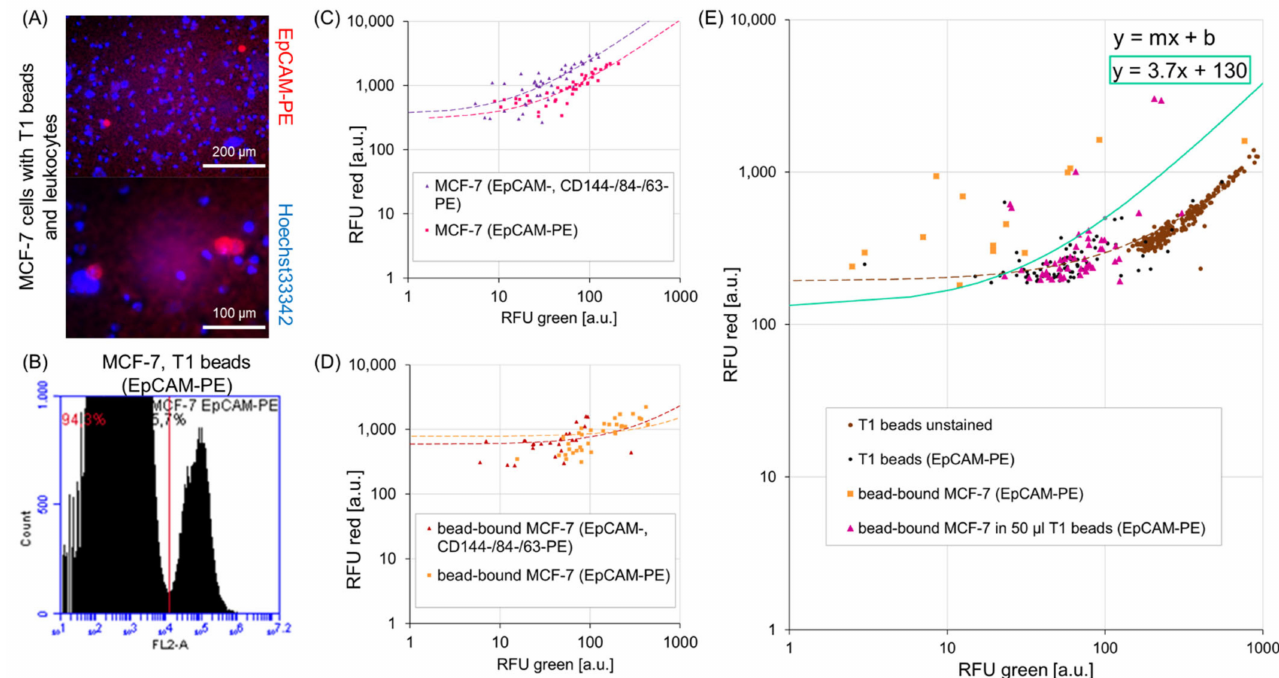
Figure 4. Selective optomicrofluidic detection of antibody-stained bead-bound MCF-7 cells. ( A ) Immunofluorescence staining of beads-enriched MCF-7 cells spiked in whole blood. Epithelial marker EpCAM-PE (red) was used and DNA was stained with Hoechst33342 (blue). Therefore MCF-7 cells are identified as EpCAM + /Hoechst + while leukocytes are EpCAM − /Hoechst + . Elevated red background signal indicates autofluorescence of excess free beads. ( B ) Relative fluorescence intensity (FL2) of sample A in flow cytometry. Objects with higher RF FL2 > 10 4 a.u. (red line) are counted as cells. The remaining counts at RF FL2 < 10 4 a.u. are defined as contaminating background signal from autofluorescent free beads or blood components. Fluorescence intensities in green- and red-sensitive channels of unbound ( C ) and bead-bound ( D ) MCF-7 cells after EpCAM-, CD144-, CD84-, CD63-PE versus EpCAM-PE staining only was then measured in the CTCelect detection unit. ( E ) Various fluorescence measurements of unstained and EpCAM-PE stained beads and MCF-7 cells in the CTCelect demonstrator. A chromatic criterion for gating following y = mx + b was introduced to distinguish between beads and cell